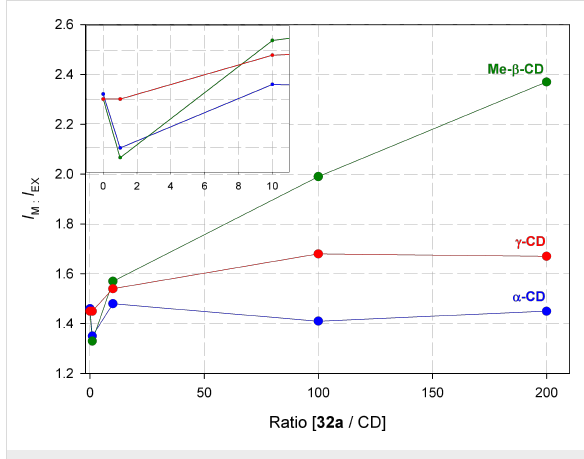
Figure 6: Monomer–excimer ratio I M / I EX of the fluorescence of 32a depending on the addition of cyclodextrines in MeOH (inset: low ratios 32a